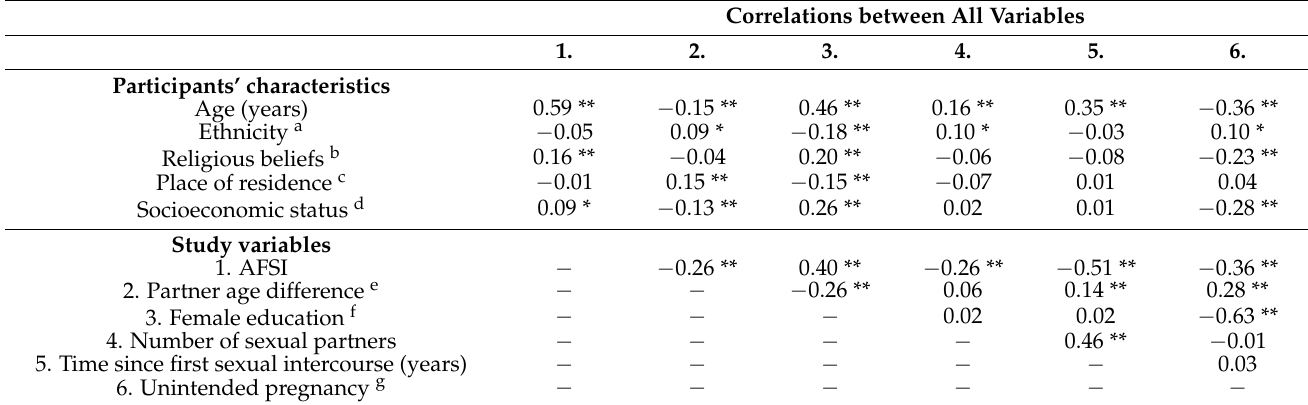
Table 2. Pearson’s Correlations for All Variables in Study.